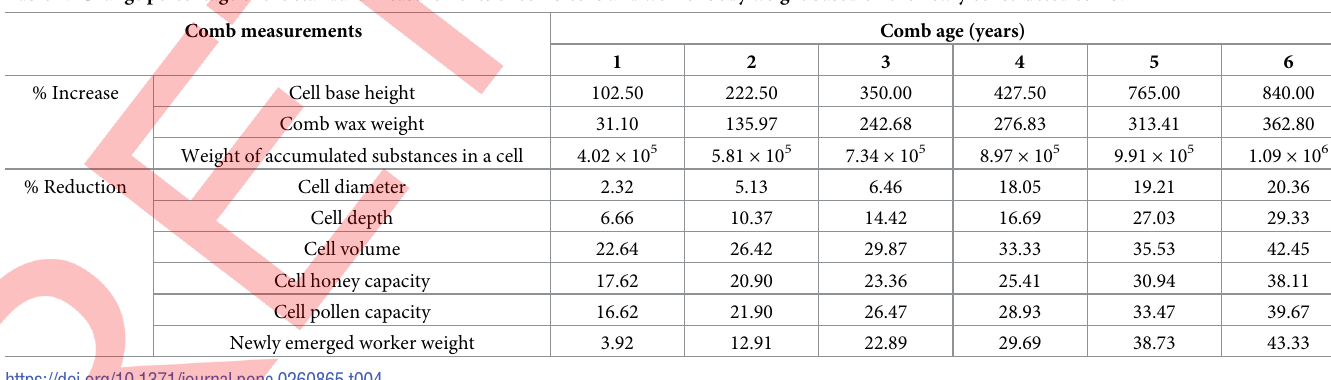
Table 4. Change percentage of the standard measurements of comb cells and worker body weight based on the newly constructed comb. Comb